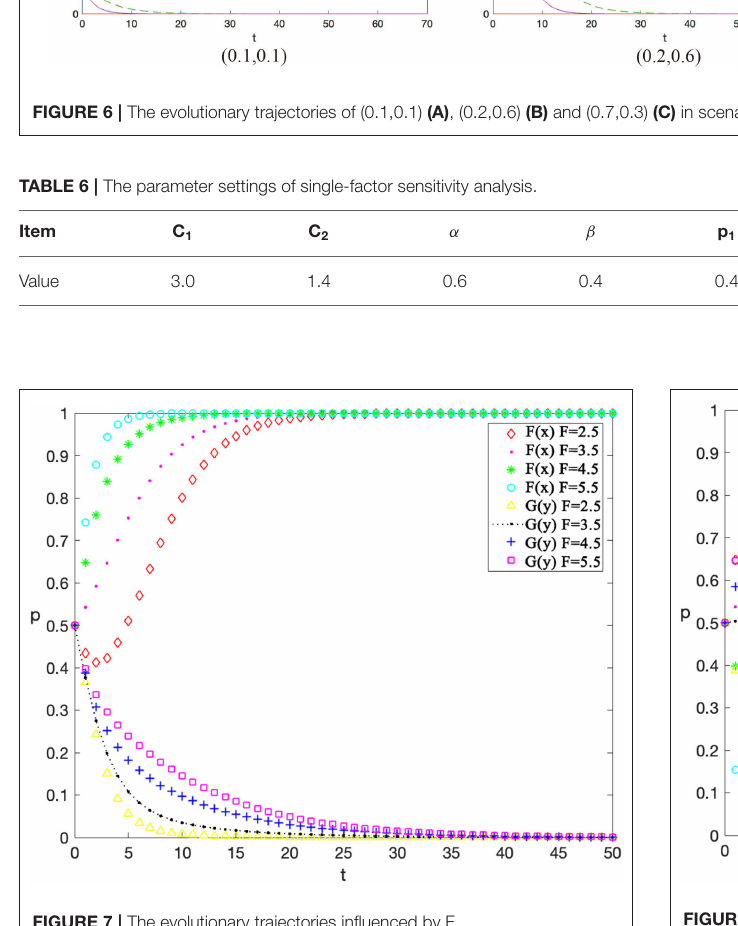
FIGURE 7 | The evolutionary trajectories influenced by F. FIGURE 8 | The evolutionary trajectories influenced by